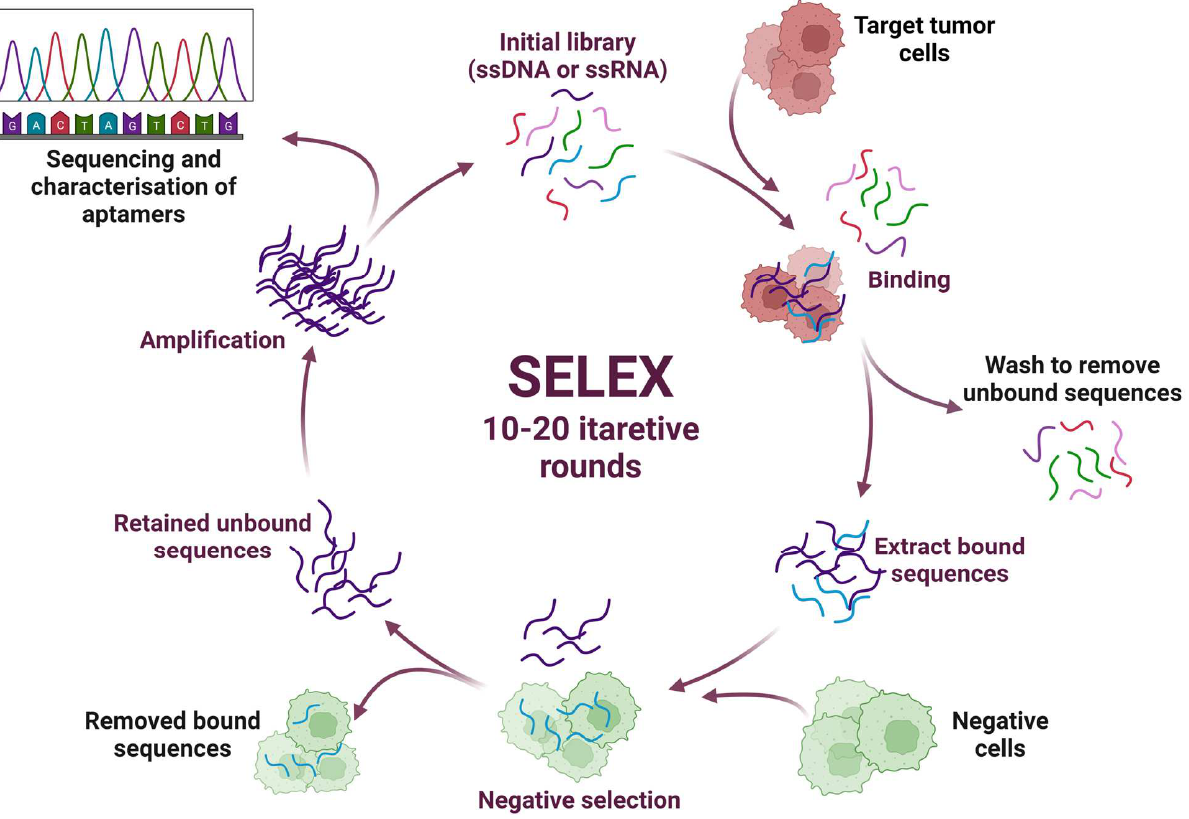
Figure 2. Schematic representation of the SELEX (systematic evolution of ligands by exponential enrichment) technology.